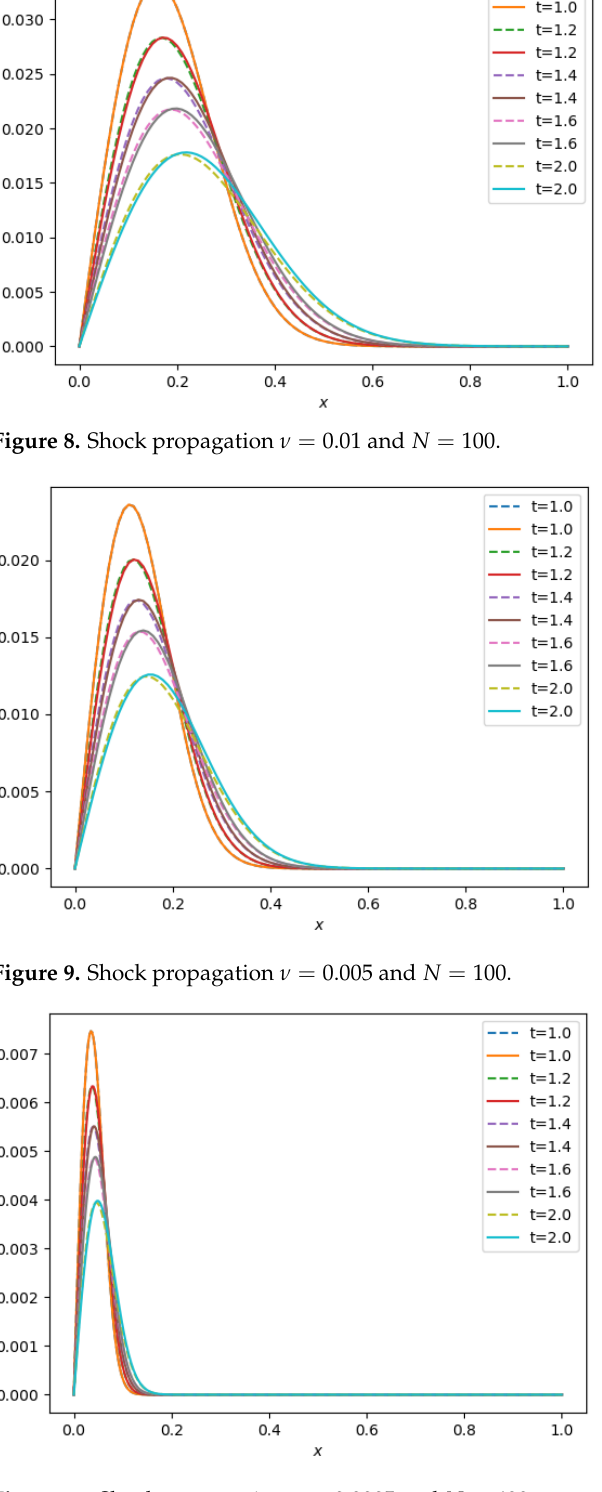
Figure 10. Shock propagation ν = 0.0005 and N =